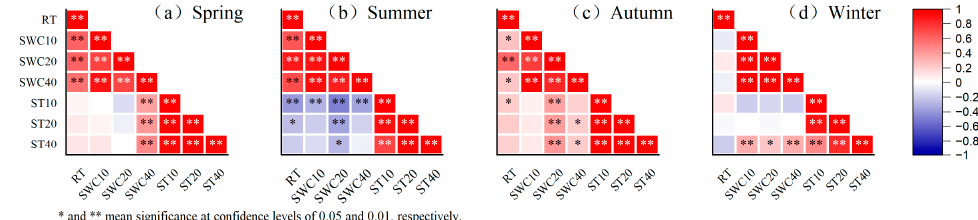
Figure 7. Correlation of soil temperature and soil water content for different soil layers and precipitation levels. ( a ) In spring. ( b ) In summer. ( c ) In autumn. ( d ) In winter.